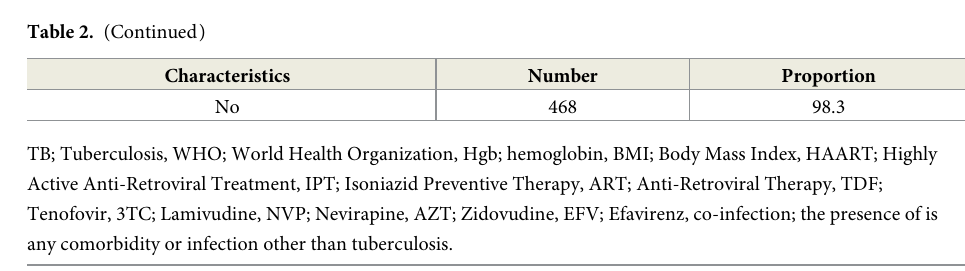
PLOS ONE | https://doi.org/10.1371/journal.pone.0232426 May 6,